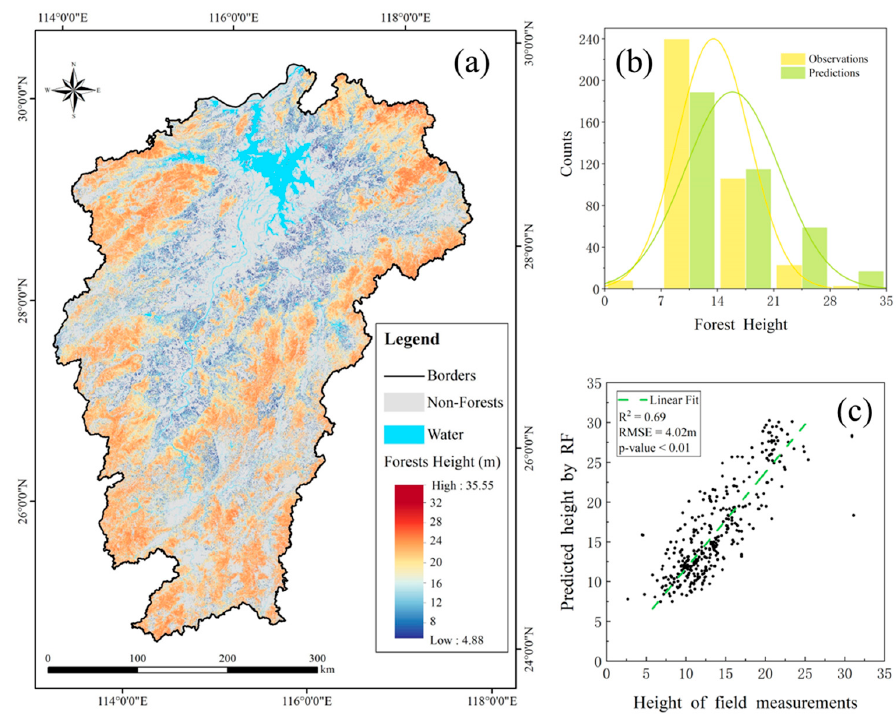
Figure 8. ( a ) A 30 m resolution forest canopy height map of Jiangxi Province based on the RF model.